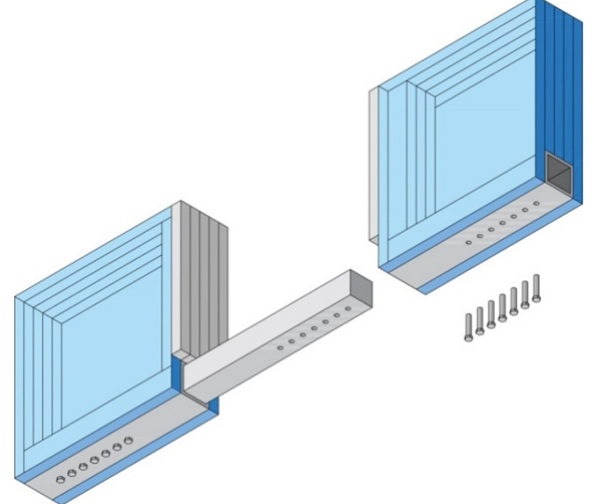
Fig 5 Transfer of tensile force by an internal coupling pin, bolted to the bottom of the